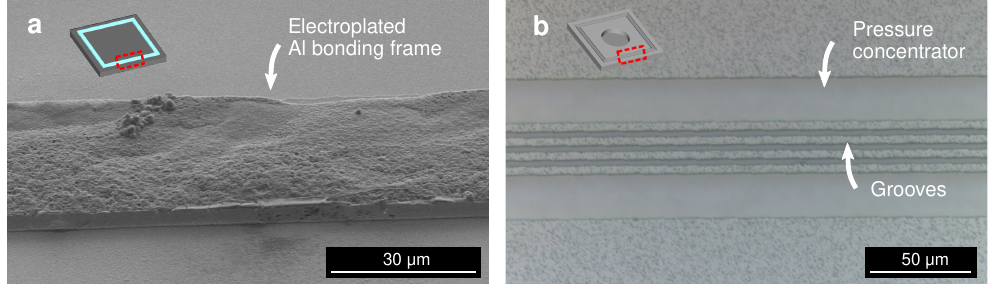
Figure 3. ( a ) Scanning electron micrograph of the electroplated Al bonding frame. ( b ) Optical micrograph of the grooves as the bonding frame at the counter